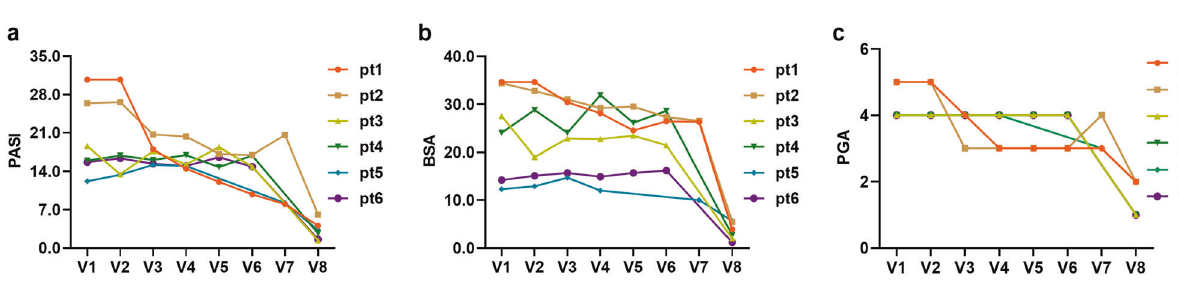
Fig. 2 The fi gure showed three outcome measures of the 6 responders including PASI score, BSA and PGA. a PASI score; b BSA; c